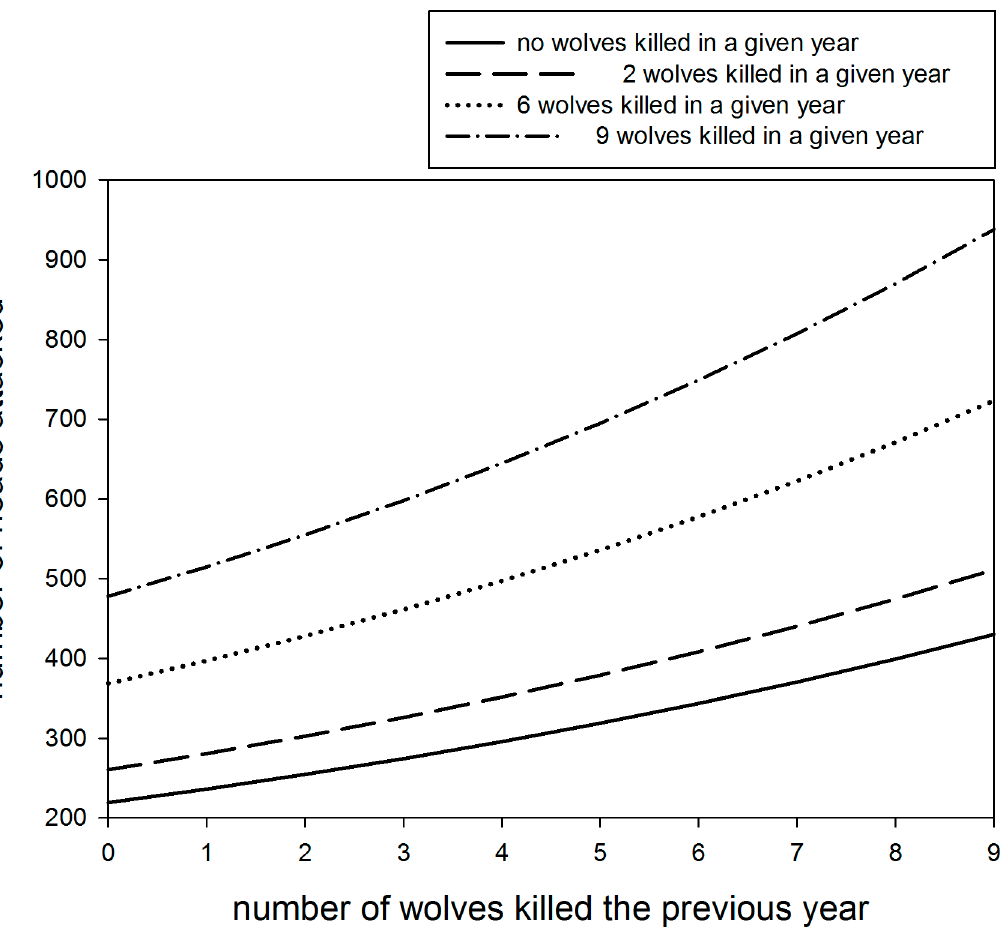
Fig 2. Relationship between the number of livestock heads depredated by wolves and number of wolves culled the previous year. The plot is based on the best model of wolf depredation on livestock; the model was parameterized for different numbers of wolves killed in the current year, and in a zone harboring the average number of packs per zone (N = 4).